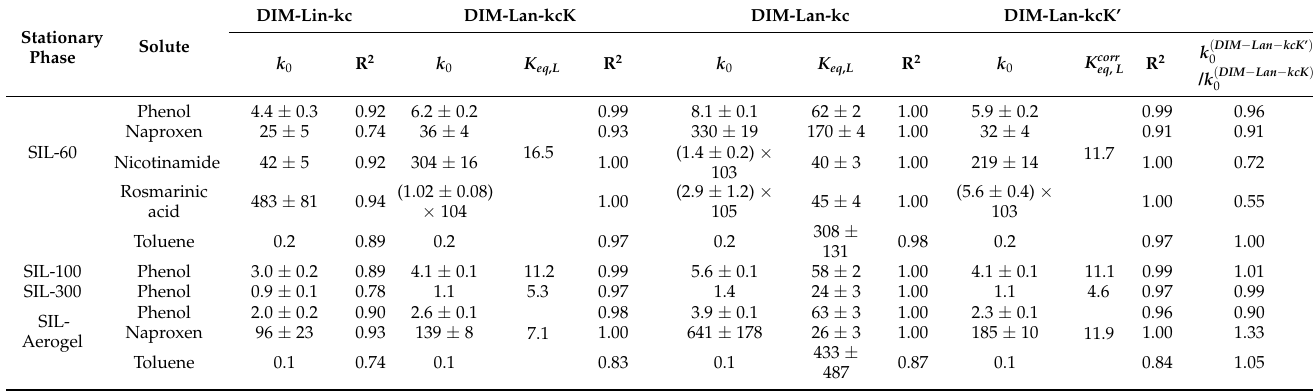
Table 4. Regression results for